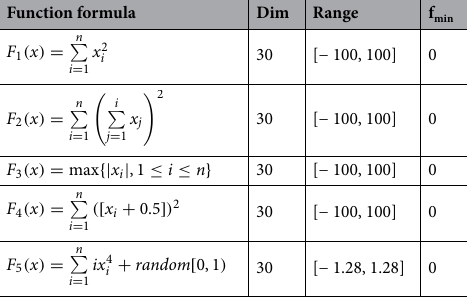
Table 2. Unimodal